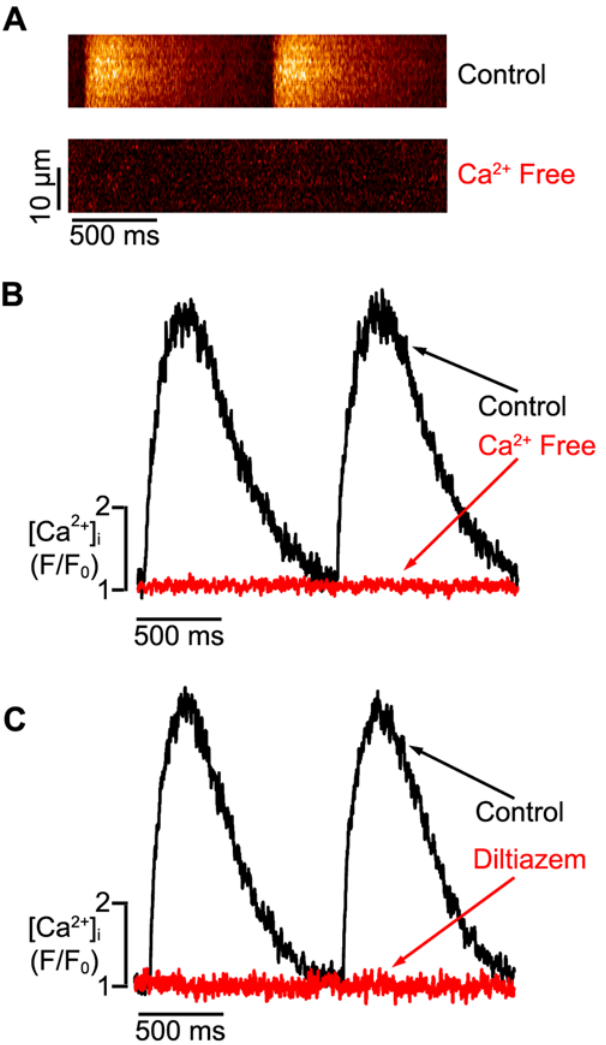
Figure 1. External Ca 2 + influx via L-type Ca 2 + channels is required for EC coupling in hESC-CMs. A. Confocal line-scan images from a representative, field-stimulated hESC-CM under control conditions (i.e. 1.8 mM external Ca 2 + , upper image) and after the application of a Ca 2 + -free solution (lower). B. Corresponding [Ca 2 + ] i transients under control (black trace) and Ca 2 + -free (red) conditions. C. [Ca 2 + ] i transients before (black) and after the application of the L-type Ca 2 + channel blocker diltiazem (10 m M, red).